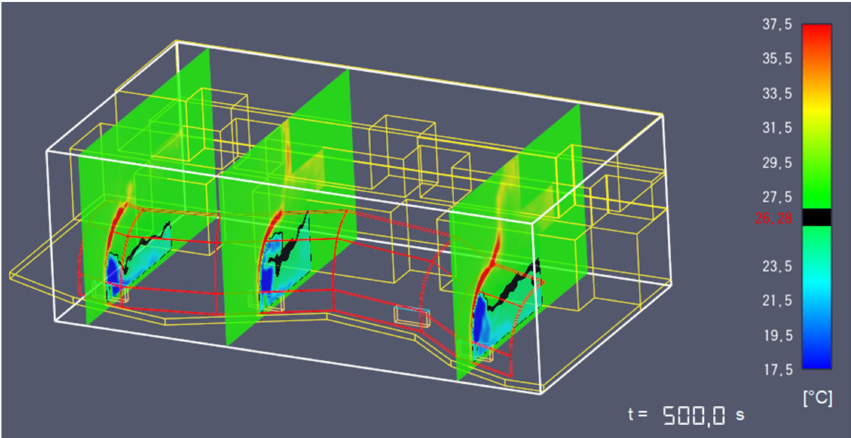
Figure 12. Reference configuration: air temperature distribution in the section y = 5 m, 10 m, 20 m, t = 500 s.